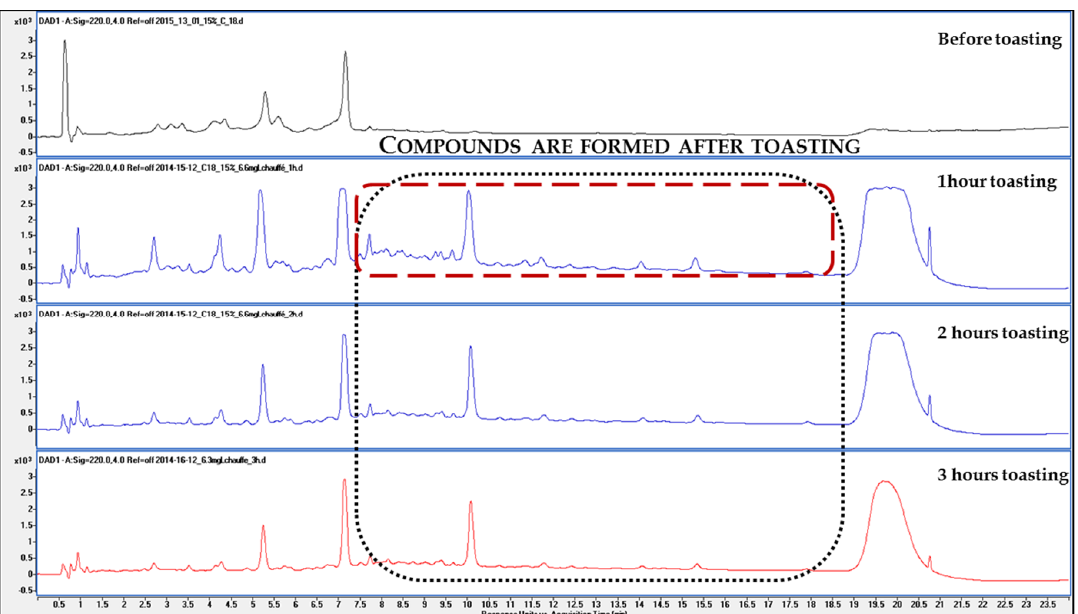
Figure A3. Compounds formed after different times of toasting.